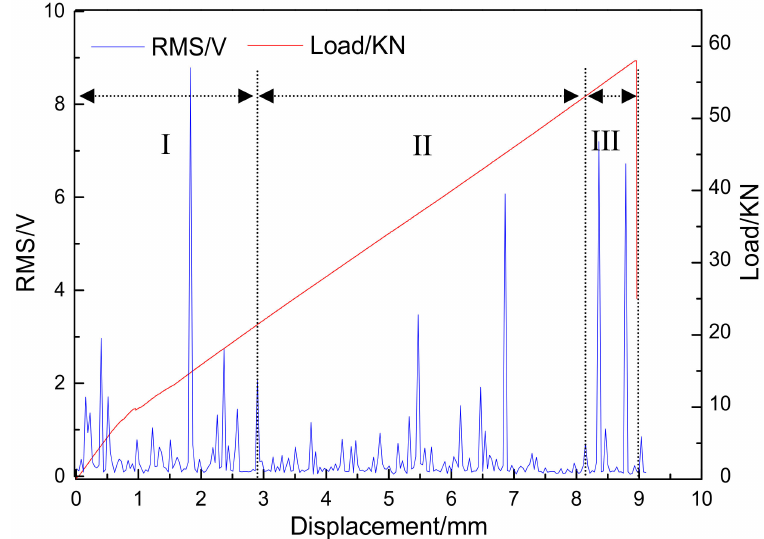
Figure 8. Change in the load–displacement curve corresponding with the AE signal RMS parameter of specimen